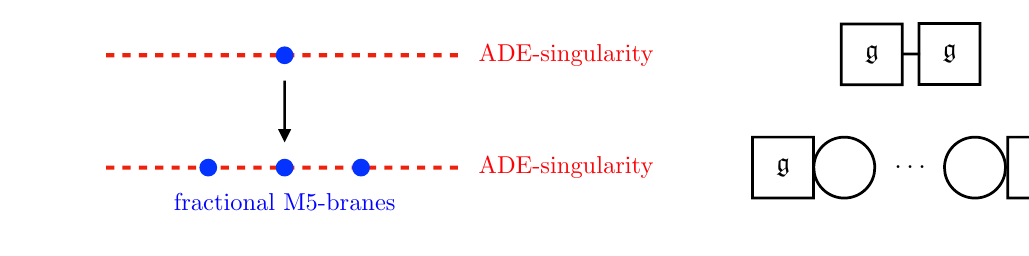
Figure 2 . M-theory setup for a superconformal